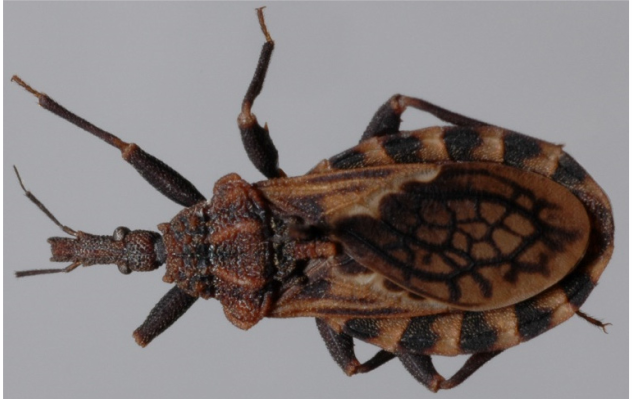
-Overall color dark brown, with several orange or yellowish areas through the body. Hemelytral membrane light brown contrasting with the dark veins. Cells